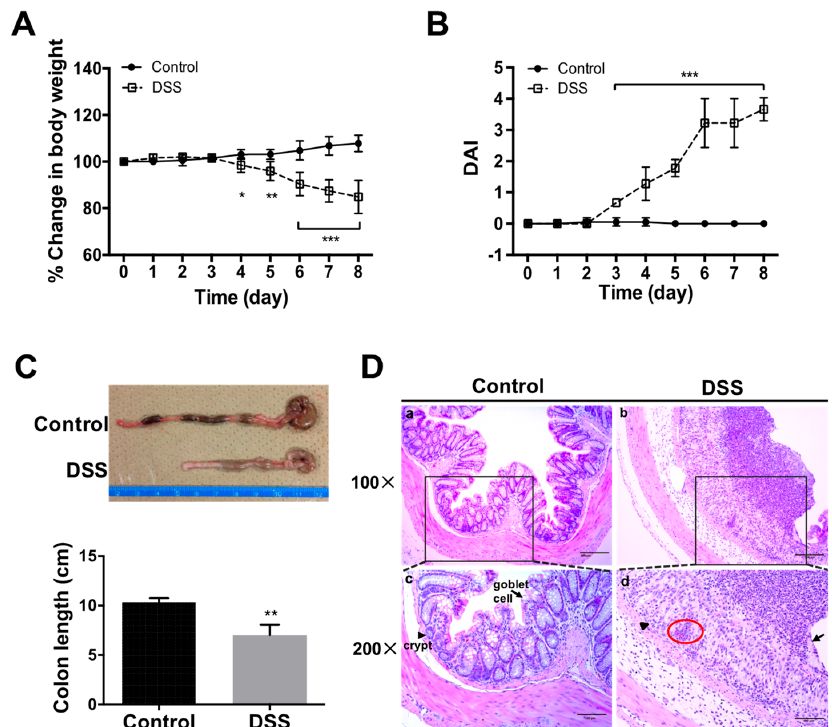
Figure 2. Macro- and microscopic changes to bowel in mice with DSS-induced colitis. Changes in body weight ( A ) and disease activity index (DAI) ( B ) were evaluated daily. Colon length was measured after sacrifice ( C ). Hematoxylin and eosin (HE) staining ( D ) showed distortion of crypts (arrowhead), loss of goblet cells (arrow), and infiltration of inflammatory cells (red circle) in colon sections from DSS-treated mice. All values are given as mean ± SEM ( n = 6 mice); * p < 0.05, ** p < 0.01, and *** p < 0.001 vs. control. Scale bars: 200 µ m ( a , b ); and 100 µ m ( c , d